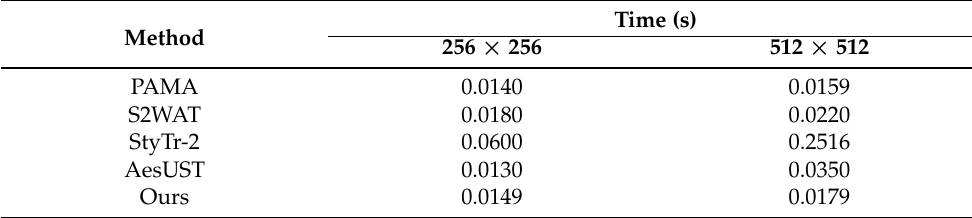
Table 1. Transfer efficiency